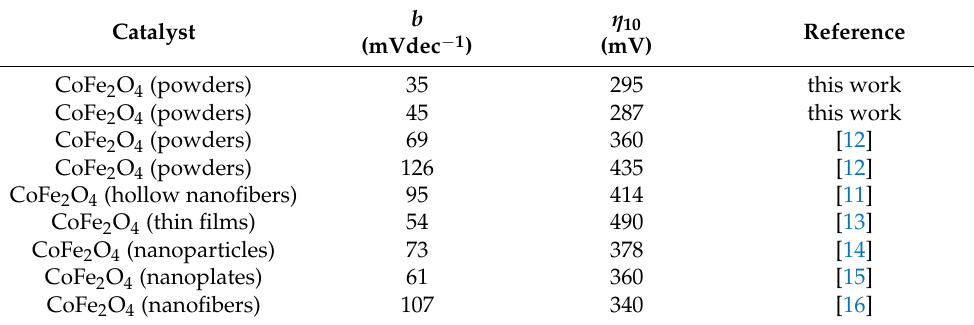
Table 2. Comparison of cobalt ferrite catalysts reported in the